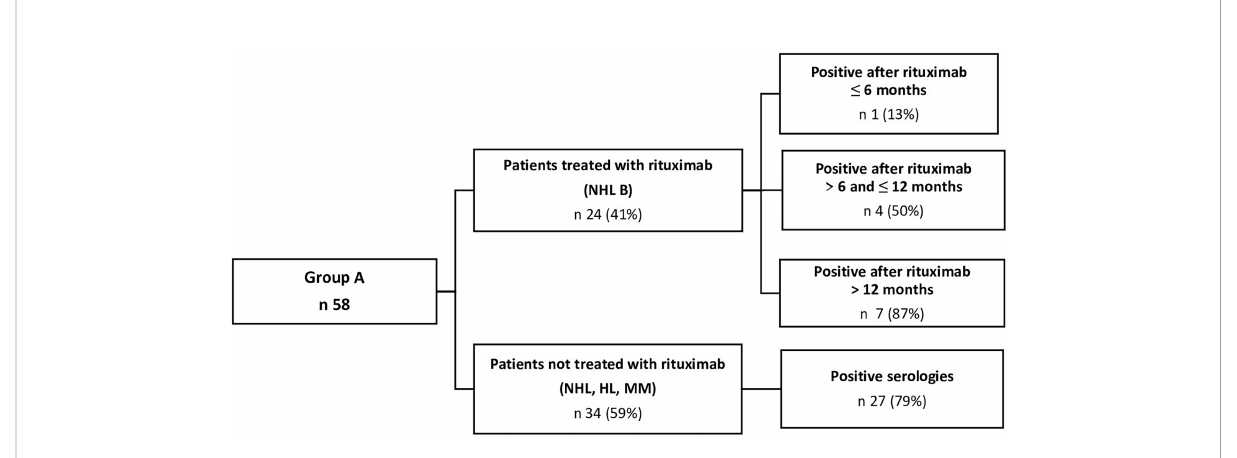
FIGURE 2 Comparison of positive serologies between patients treated and not treated with Rituximab when vaccinated after aHSCT (group